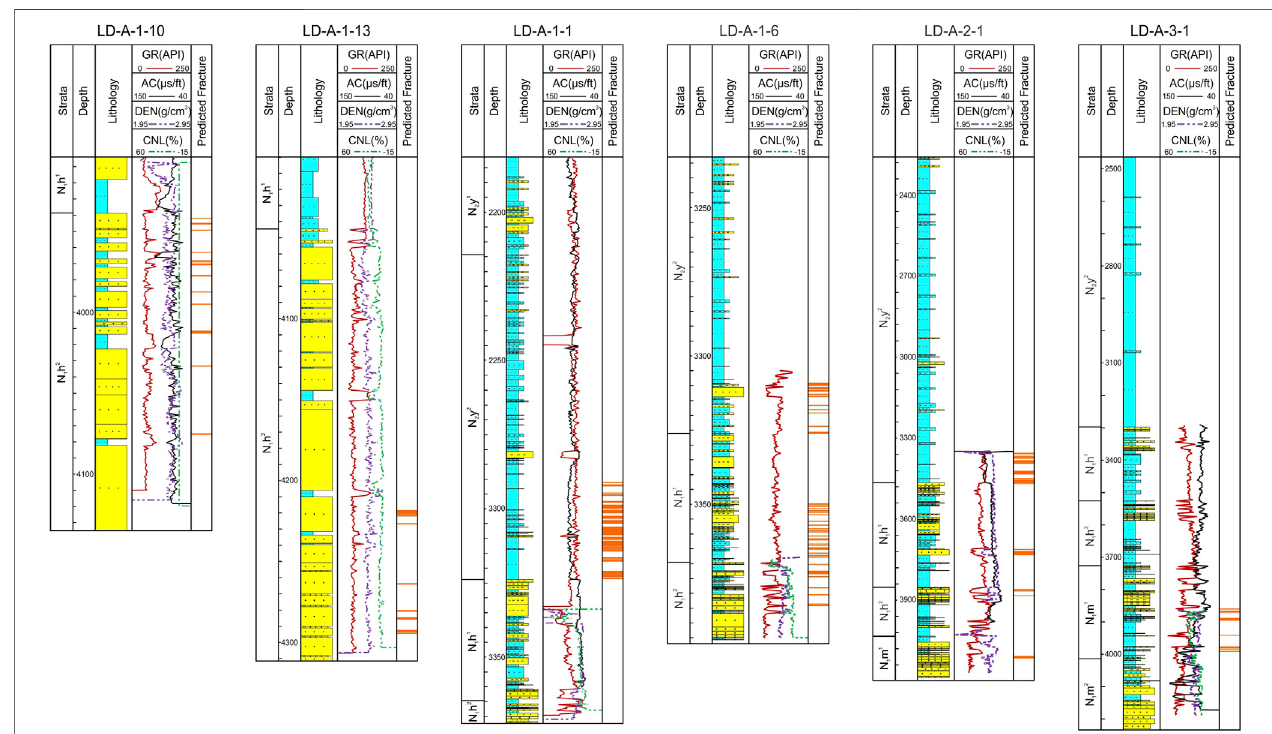
FIGURE 12 | Well section pro fi le showing the fracture-developed intervals identi fi ed from conventional logging in the LD-A gas fi eld.